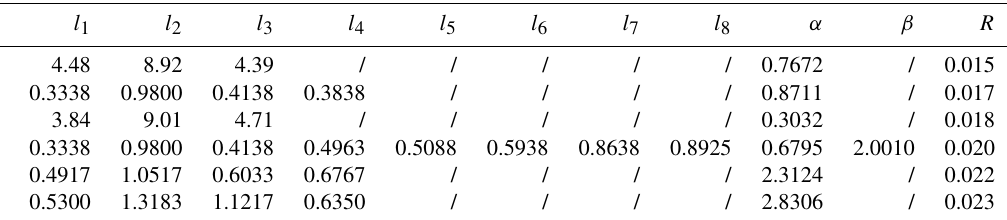
Figure 12. The circle-tracing training motion and its trajectory of wrist. Table 1. Linkage parameters of the